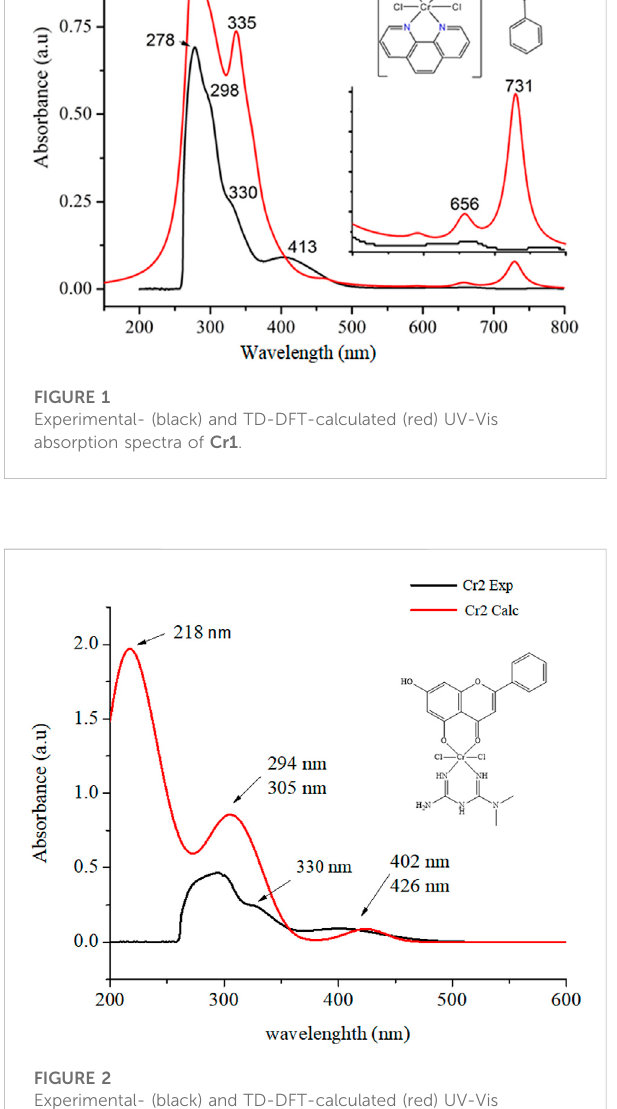
Figure 2 and Supplementary Figures S3 – S5 in the Supporting Material.